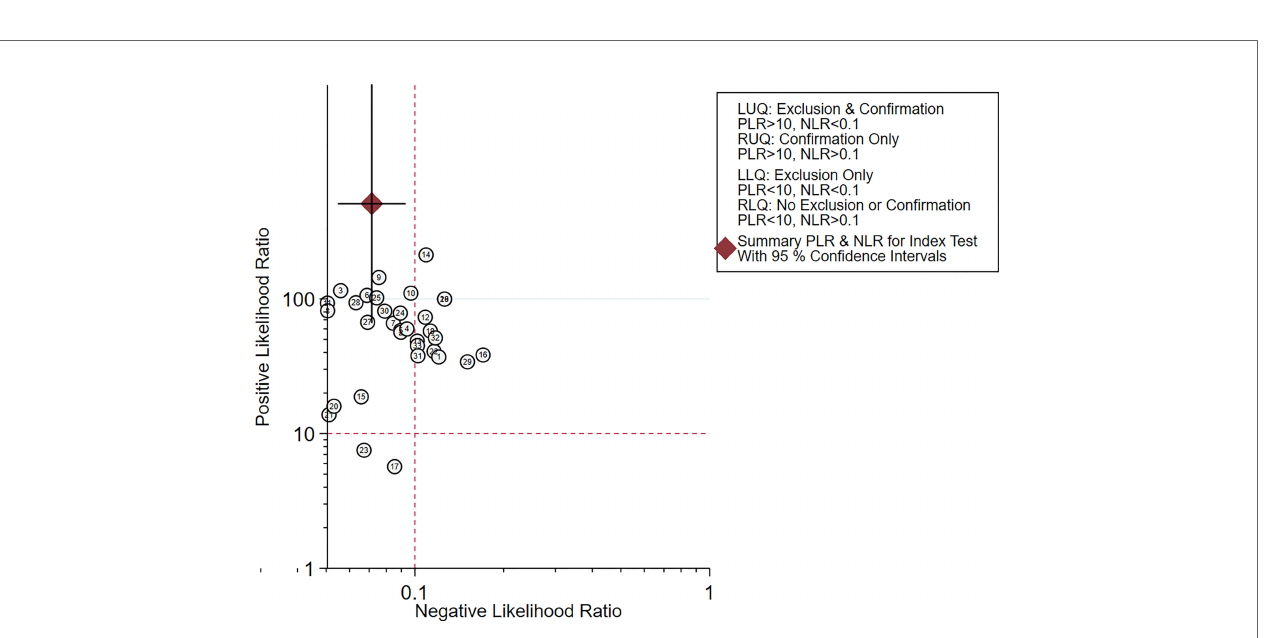
FIGURE 8 | Scattergram of the PLR and NLR of the diagnosis value of CNSs in SLNB of breast cancer. PLR, positive likelihood ratio; NLR, negative likelihood ratio; LLQ, left lower quadrant; LUQ, left upper quadrant; RLQ, right lower quadrant; RUQ, right upper